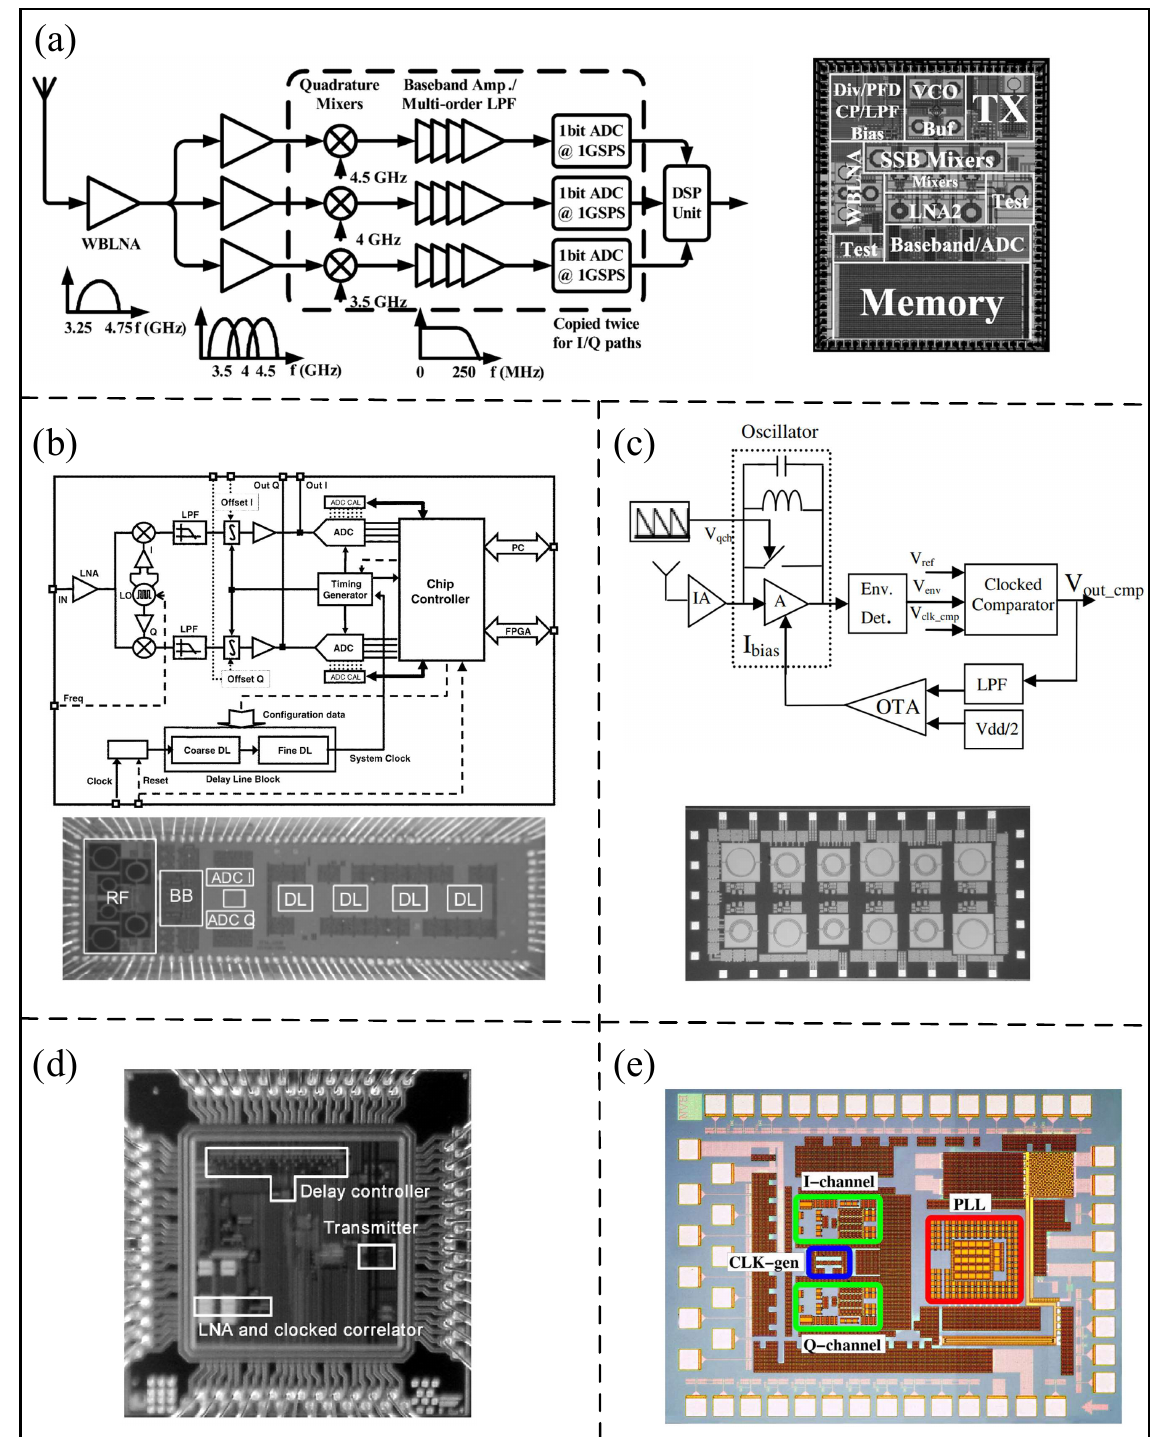
Figure 9. ( a ) Frequency channelized receive and chip micrograph. (Reprinted from [57], Copyright 2008, with permission from IEEE). ( b ) Quadrature analog correlating architecture and receiver chip mi-crophotograph. (Reprinted from [58], Copyright 2007, with permission from IEEE). ( c ) Block dia-gram of Super regenerative receiver and die photograph for UWB receiver. (Reprinted from [59], Copyright 2007, with permission from IEEE). ( d ) Chip microphotograph. (Reprinted from [60], Copyright 2006, with permission from IEEE). ( e ) Key performance of different modules and die photo. (Reprinted from [61], Copyright 2009, with permission from